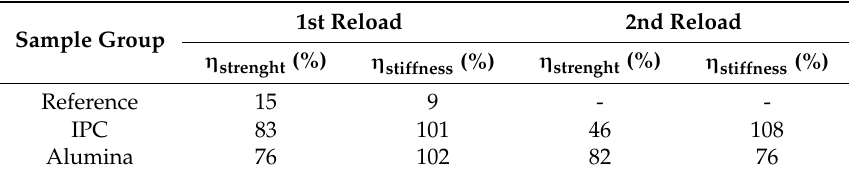
Table 3. The mechanical recovery for the beams carrying piping network under four-point-bending.